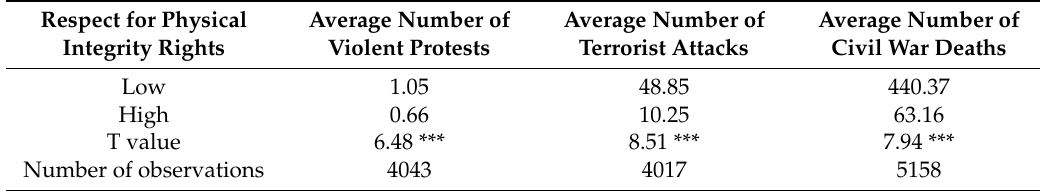
Table 1. Physical Integrity Rights and Conflict Events.